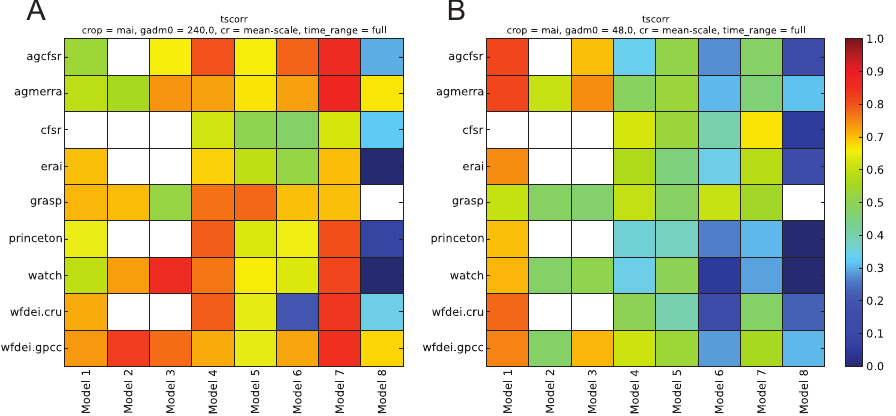
Figure 7. Examples of cross sections of the multi-metric evaluation array for the top two maize-producing countries – the United States (a) and China (b) . Plot shows time series correlations for eight different crop models run ( x axis) with nine different climate forcing data sets ( y axis). For each model/climate combination, the best metric value among the scenarios (default, fullharm, and harmnon) and de-trending methods (linear, quadratic, moving mean, and trend-removed fraction first difference) are